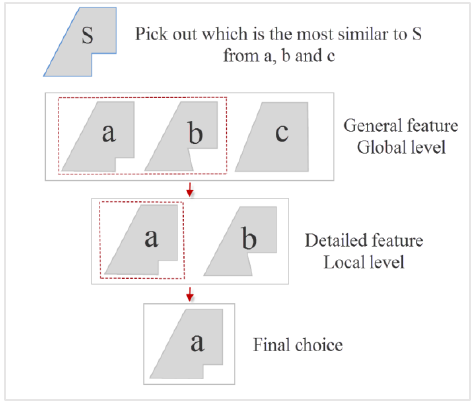
Figure 2. Feature comparison at the global and local levels.